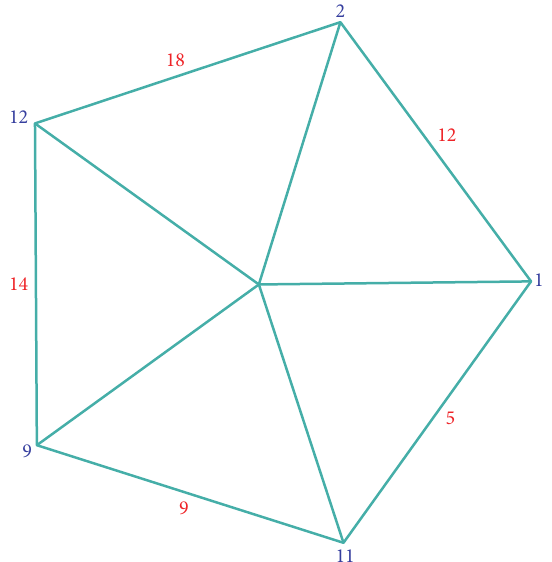
Figure 10: The pentagon Δ 𝐿 ; its vertices and facets are suitably